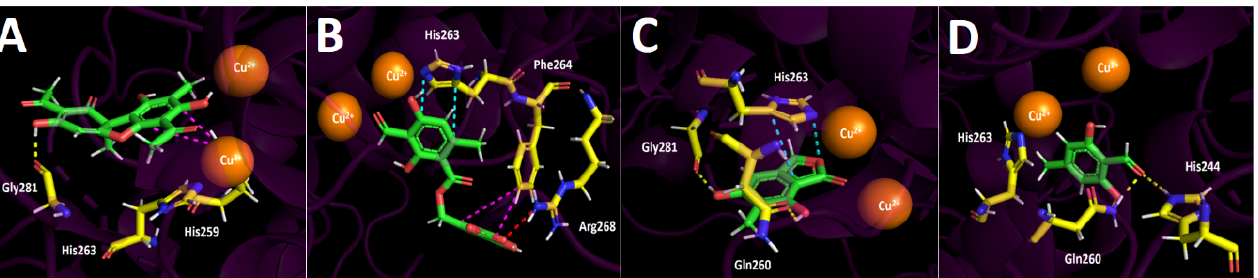
Figure 6. Predicted binding mode and predicted intermolecular interactions of the selected major compounds obtained from H. lugubris extract and the residues of the Agaricus bisporus mushroom tyrosinase catalytic site. Yellow dotted lines indicate hydrogen bond interactions, cyan dotted lines represent π – π interactions, magenta dotted lines represent T-shaped interactions, and red dotted lines represent salt bridges. ( A ) Usnic acid in the catalytic site; ( B ) barbatolic acid in the catalytic site; ( C ) 5,7-dihidroxy-6-methylphthalide in in the catalytic site; ( D ) atranol in the catalytic site. Furthermore, 7-Dihydroxy-6-methylphthalide and atranol possess similar binding energies. In the same sense, the IC 50 values of these two derivatives were in the same range (12.13 ± 0.15 ppm and 7.25 ± 0.18 ppm, respectively). Within the tyrosinase active site, both